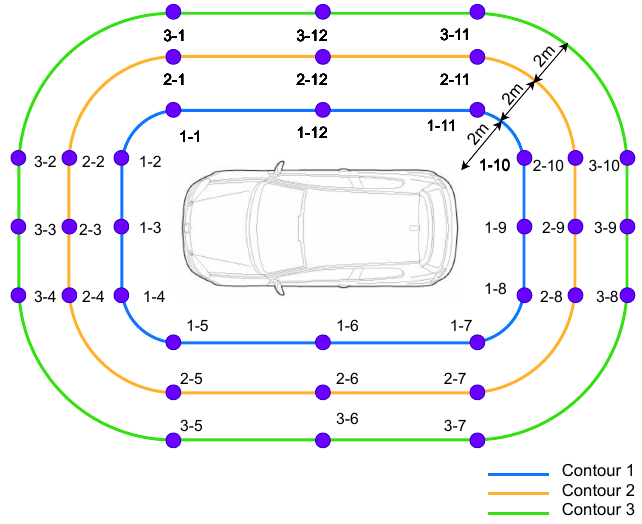
Figure 6. Data collecting points. The collecting points are labelled as purple dots. Contour 1 was 2 m from the car’s bounding rectangle, contour 2 was 4 m from the car’s bounding rectangle, and contour 3 was 6 m from the car’s bounding rectangle.